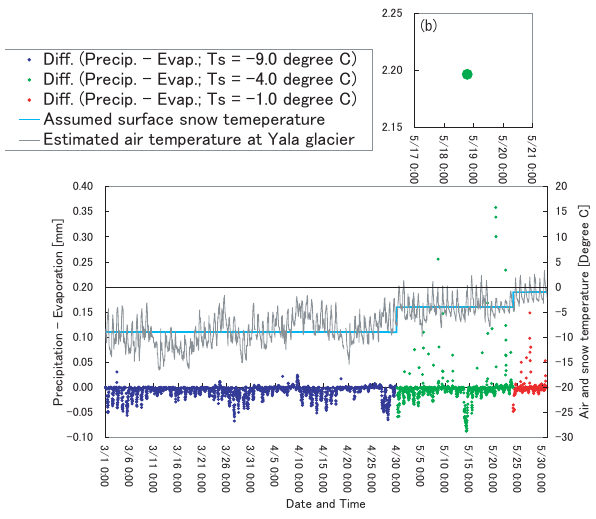
ration ( E ) (sublimation in this study). The constant snow surface temperatures of − 9, − 4, and − 1 ◦ were used during 1 March–29 April, 30 April–23 May, and 24 May–31 May, respectively. One data in P − E at the time of Event A was located out of range and plotted in Fig. 5b separately. In Fig. 5b, vertical and horizontal axes have the same units as Fig.